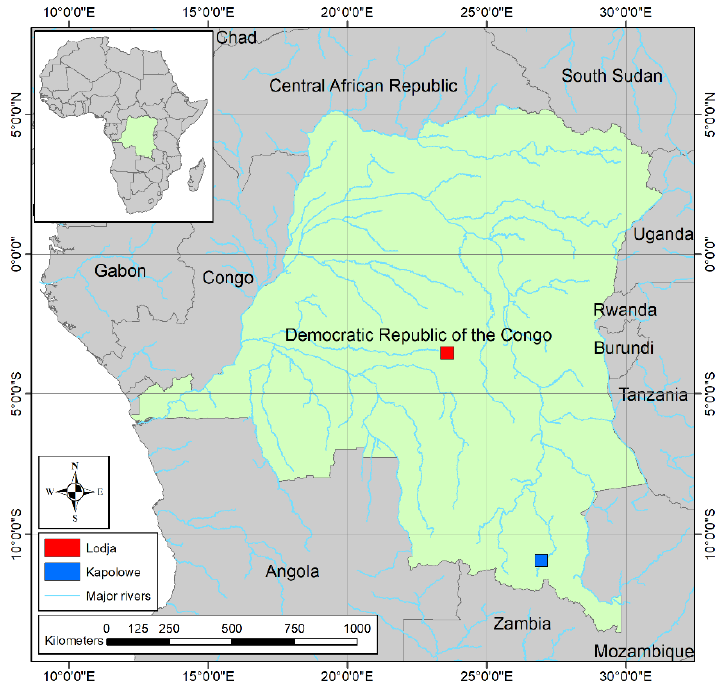
Figure 1. Lodja and Kapolowe study areas.